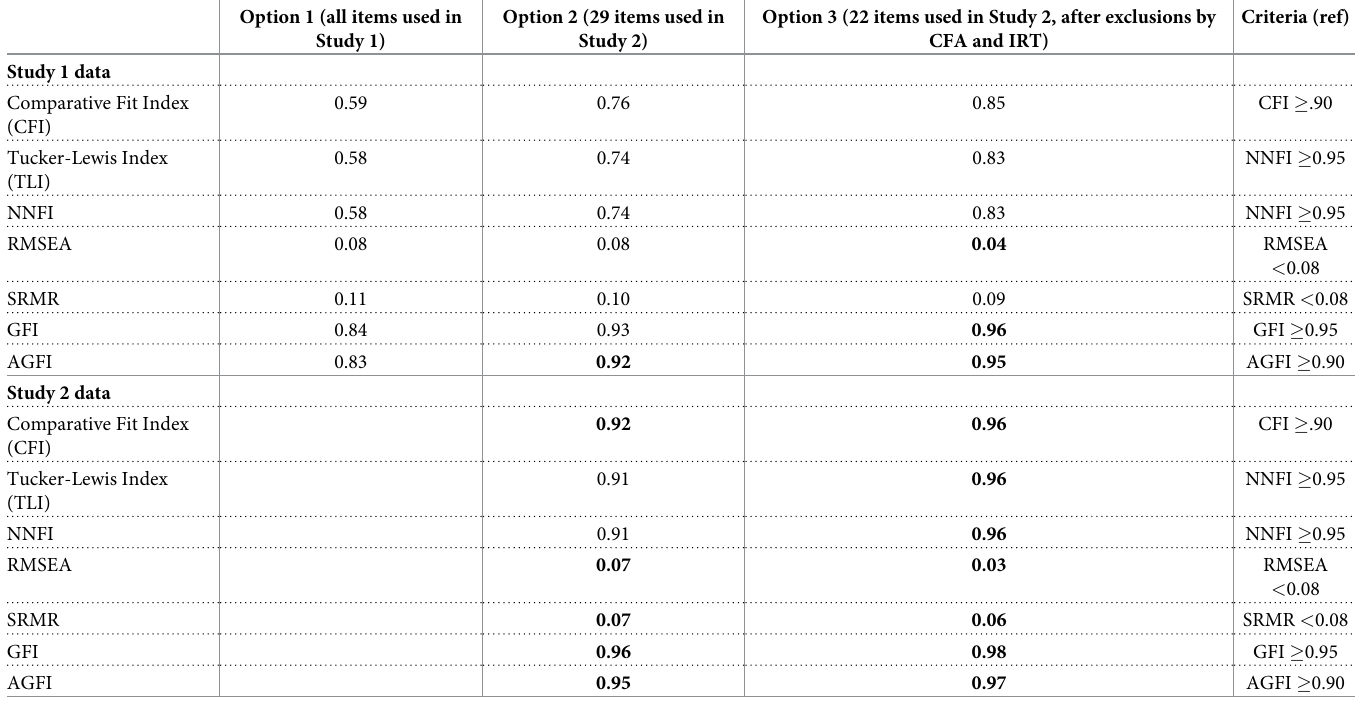
Table 6. Detailed goodness-of-fit of models for CFA of three different versions evaluated in Study 1 and Study 2 data. Option 1 (all items used in Study